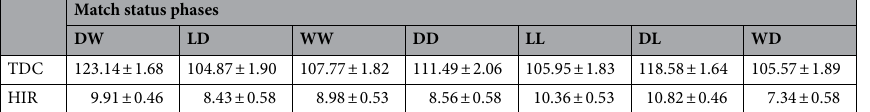
Table 2. The relation between TDC [m·min -1 ], HIR [m·min -1 ] and match status phases (mean ± SE). TDC— total distance covered; HIR—distance covered in high-intensity running (speed > 19.8 km h −1 ). DW (Drawing to Winning); LD (Losing to Drawing); WW (Winning to Winning); DD (Drawing to Drawing); LL (Losing to Losing); DL (Drawing to Losing); WD (Winning to Drawing).